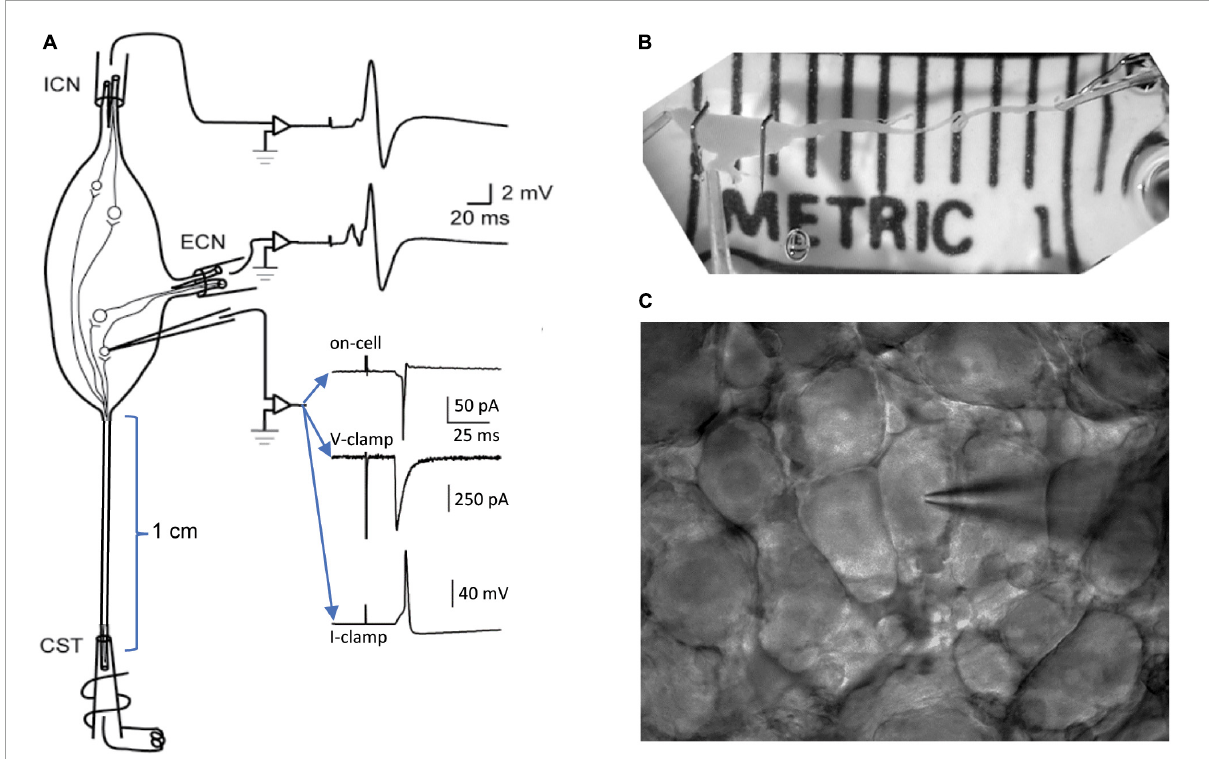
FIGURE1 Methods for patch recording from the isolated superior cervical ganglion (SCG). (A) Schematic organization of the experimental preparation. Tight-fitting extracellular suction electrodes are applied to the preganglionic cervical sympathetic trunk (CST) and to the postganglionic internal carotid nerve (ICN) and external carotid nerve (ECN). Graded presynaptic stimulation is used to recruit and resolve converging synapses. The efficacy of presynaptic stimulation is monitored by recording compound extracellular responses from the ICN and ECN. A patch electrode is used to record extracellular and intracellular responses from individual neurons. Examples of recordings show an on-cell extracellular response, an intracellular synaptic current and an intracellular EPSP that triggers an action potential. (B) Photograph of a dissected rat SCG in the recording chamber after removal of the connective tissue sheath and application of suction electrodes. Note the long CST, which allows synaptic components to be separated by variations in axonal conduction velocities. Note also the two stainless pins gently holding down the ganglion. At this stage of preparation the ganglion is ready for collagenase treatment. (C) A field of sympathetic neurons and a patch electrode visualized through a 40 × water immersion objective and charge-coupled device (CCD) camera, ready for